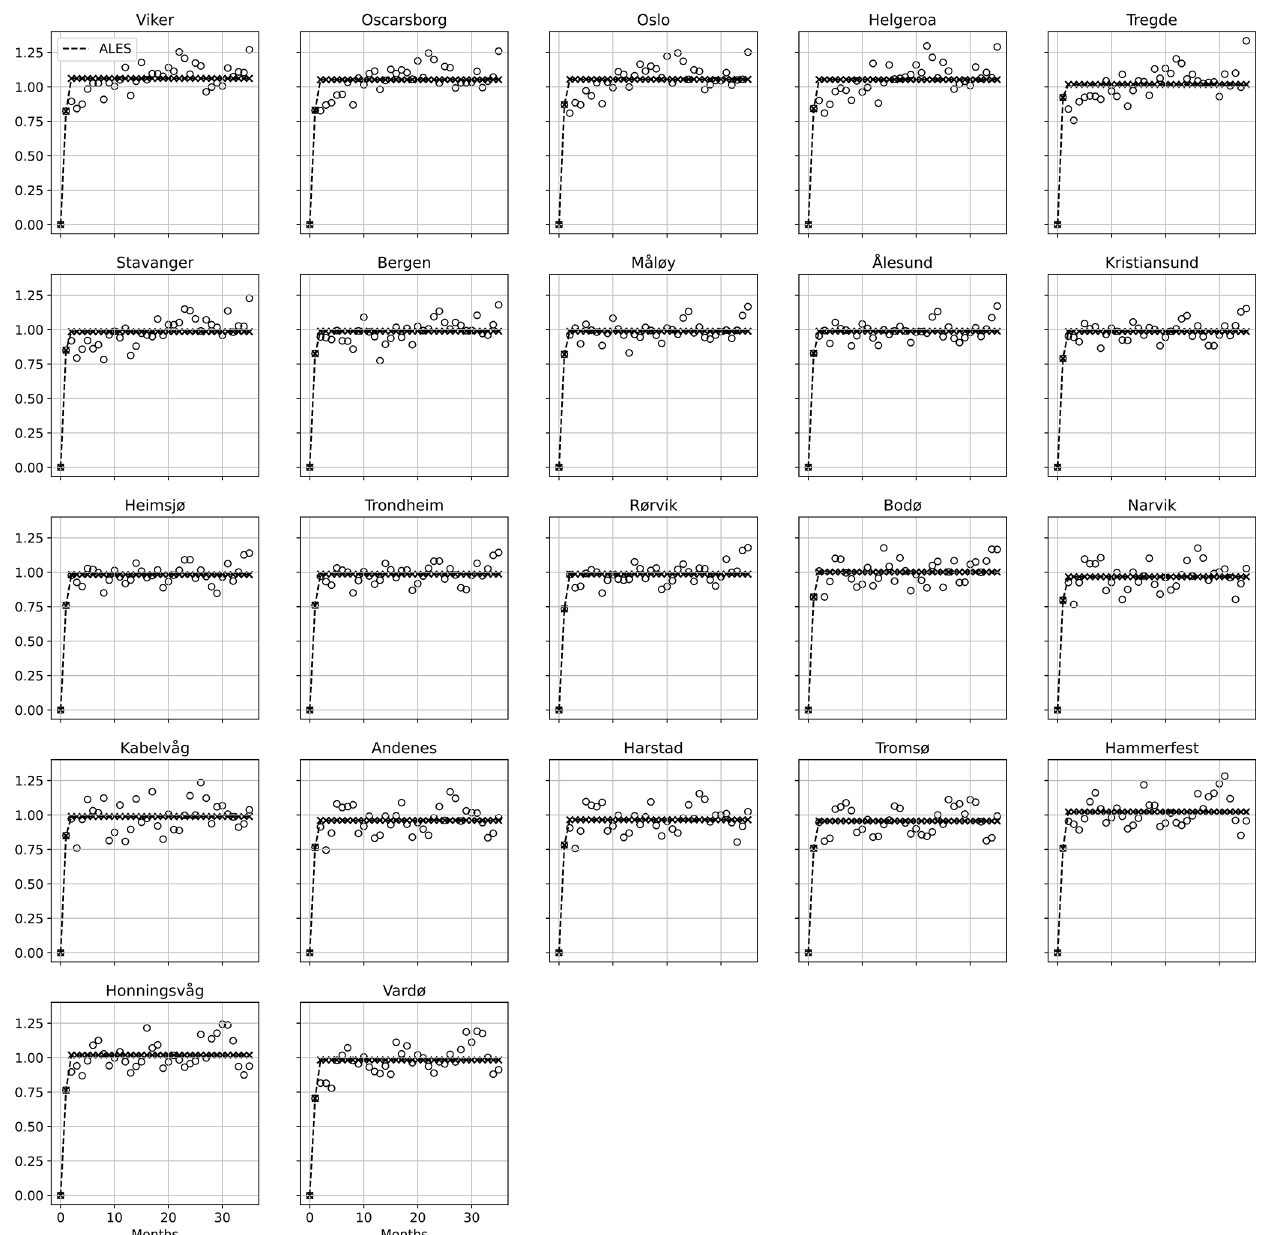
Figure A1. For each tide gauge along the Norwegian coast, semi-variogram of the detrended and deseasoned SLA estimated from the ALES- retracked satellite altimetry (empty circles) and corresponding fit (crosses connected by a dashed line). At each tide-gauge location, we scaled each semi-variogram by the variance of the corresponding detrended and deseasoned SLA for all the plots to have the same limits on the y